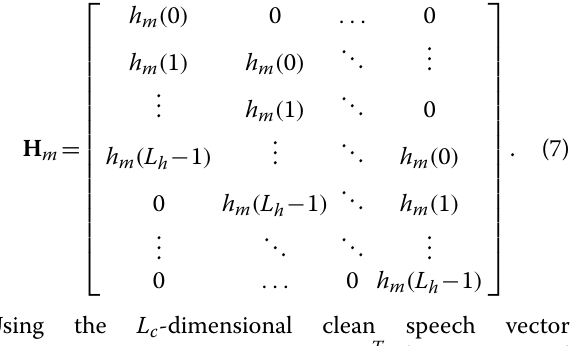
Using the filter-and-sum structure in Fig. 1, the output